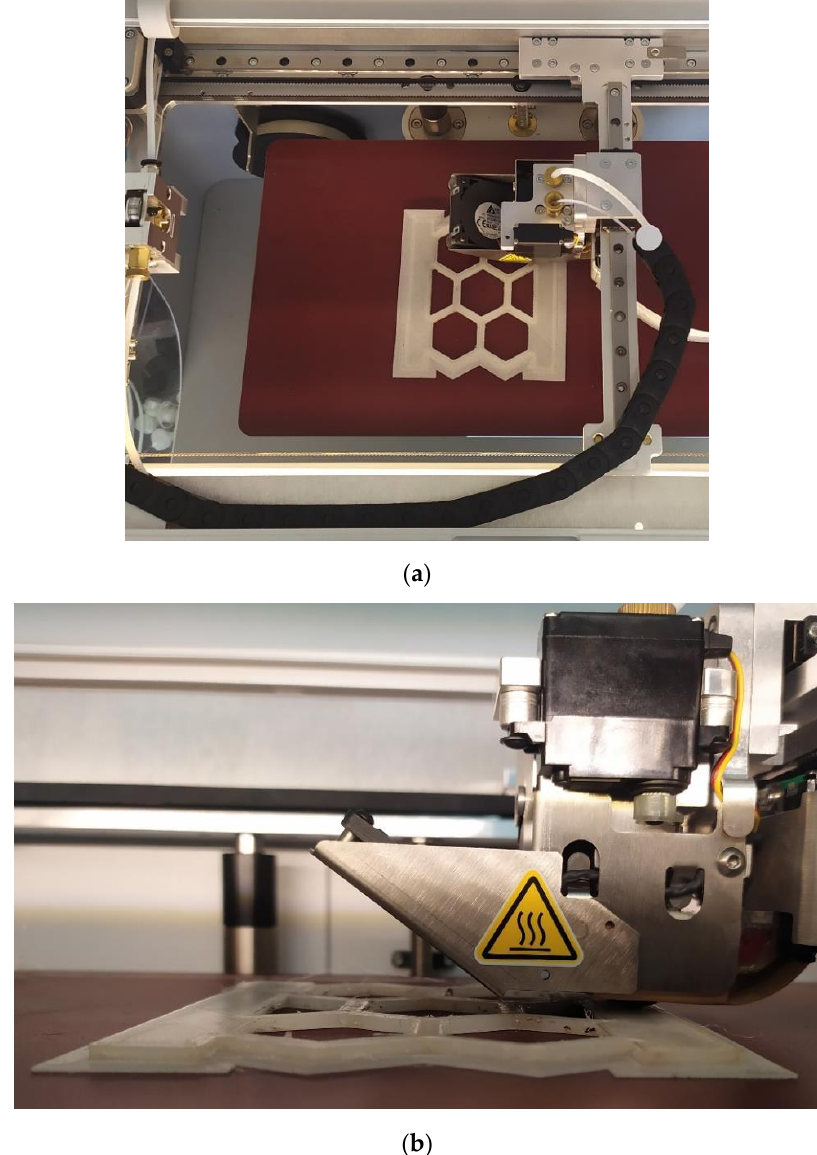
Figure 4. ( a ) Top and ( b ) side views of the 3D printing process of the fiberglass-reinforced honeycomb structure.